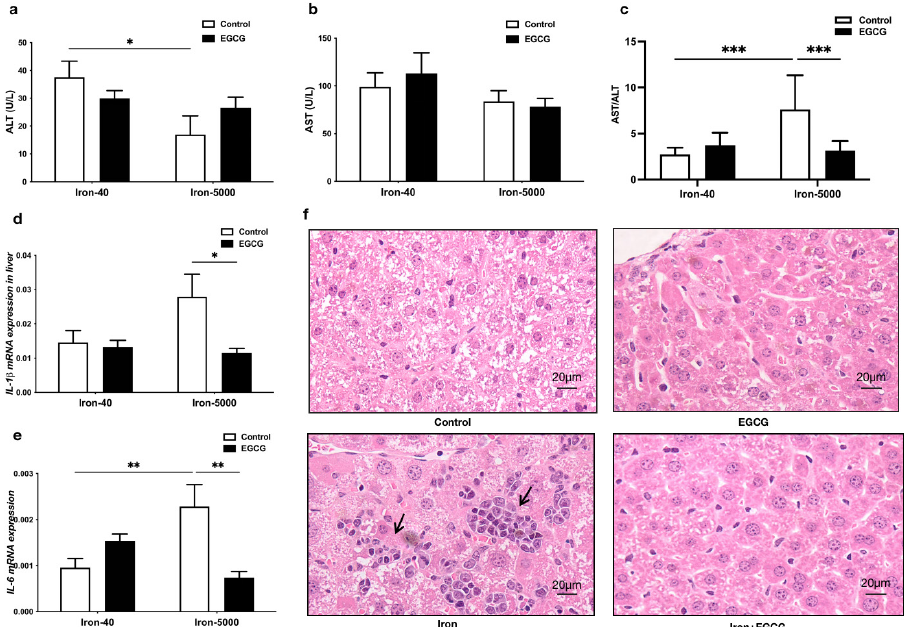
Figure 4. EGCG addition attenuates liver damage and inhibits the mRNA expression of proinflam- matory cytokines. ( a – c ) Serum ALT, AST, and ALT/AST levels were determined ( n = 10). ( d , e ) The mRNA expression of proinflammatory cytokines IL-1 β and IL-6 were tested by qPCR ( n = 10). ( f ) The HE-stained sections of mouse liver tissues ( n = 5). The arrows point to areas of inflammatory infiltration in the liver. Scale bar, 20 µ m. The results of the two-way ANOVA are denoted by p -values, p < 0.05 (*), p < 0.01 (**), p < 0.001(***).